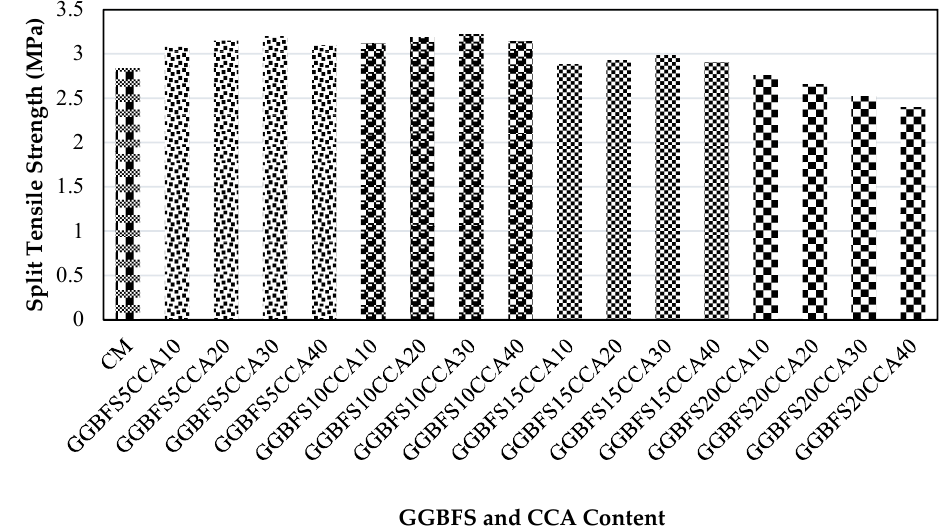
Figure 13. Splitting tensile strength of concrete blended with GGBFS and CCA.